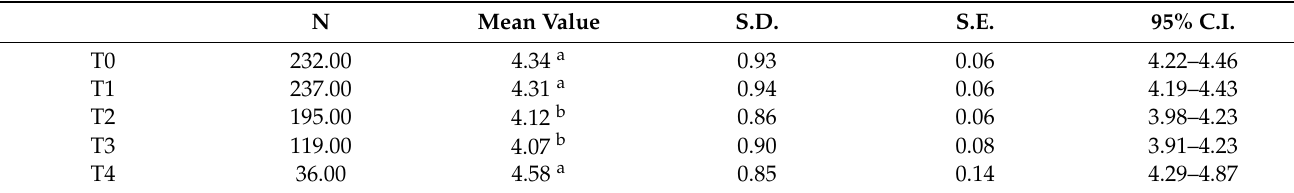
Table 3. ANOVA results of mental restoration of the students at different times of stay in school. N Mean Value